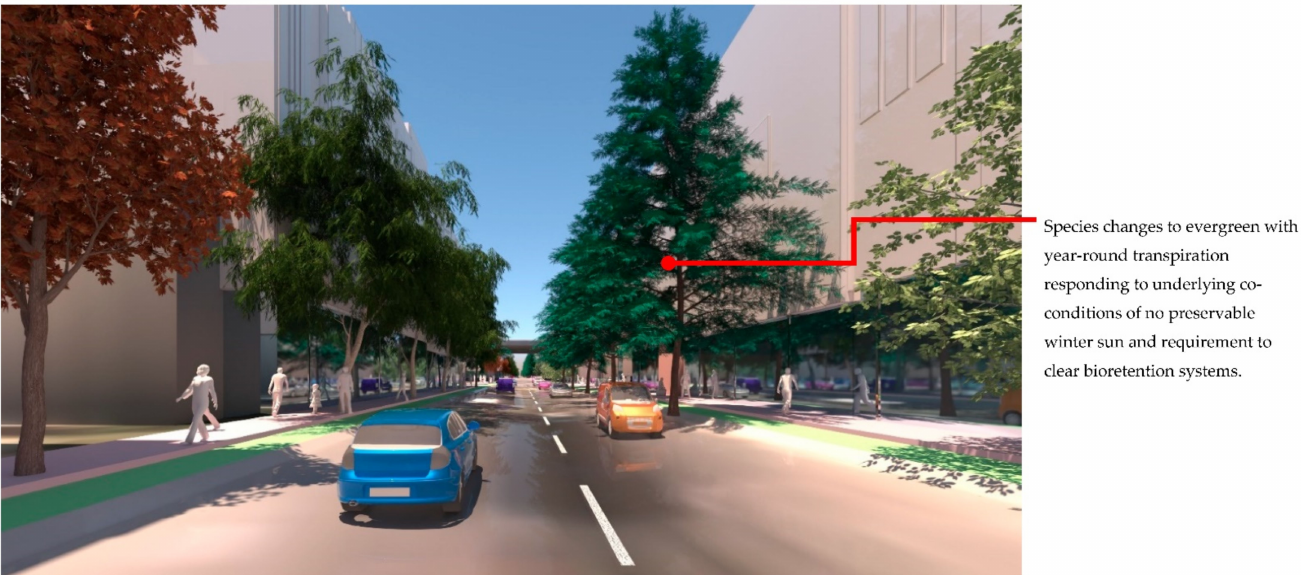
Figure 18. Macaulay Road view of Flood scenario (2) ‘road-based integrated water management’ during dry weather. In both schemes trees on the right-hand side are positioned in the road just beyond the bike path to achieve the summer active transport objective. Image by authors using multi-criteria street tree design decision support modelling approach in Autodesk™ 3ds